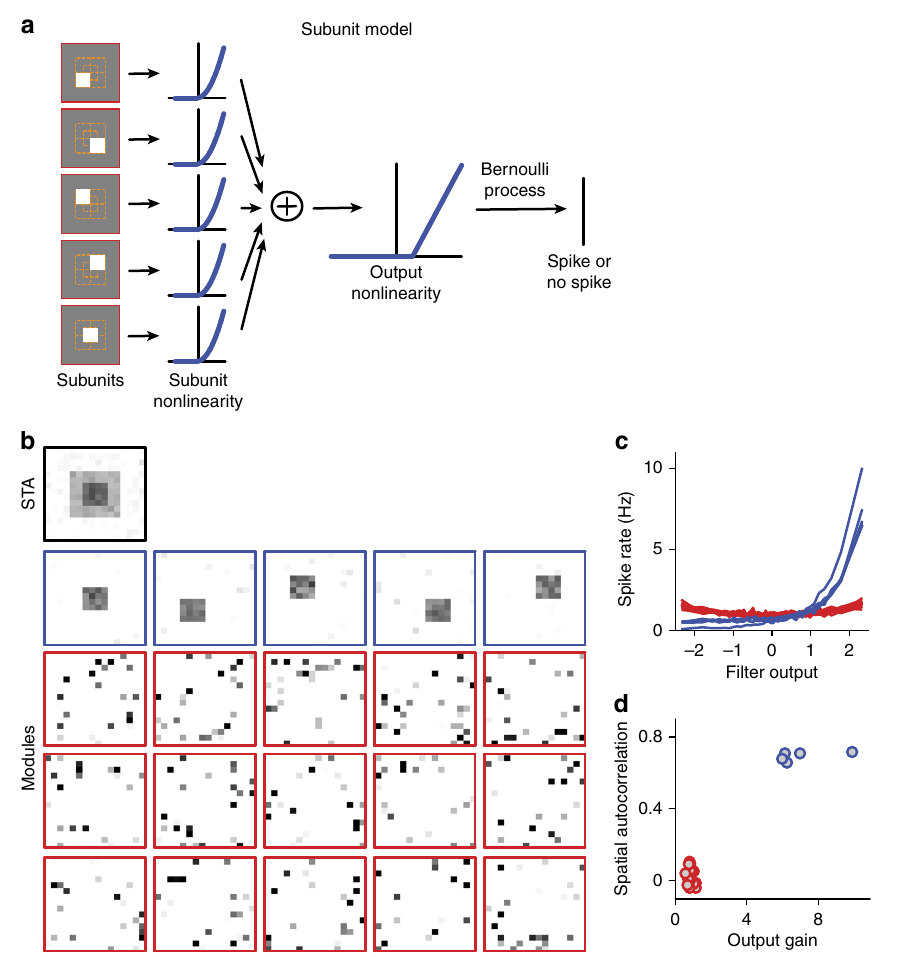
Fig. 2 Identi fi cation of overlapping subunits with STNMF for a model neuron. a Model structure. Stimuli are here spatial patterns of 16 × 16 pixels of Gaussian white noise. The model contains fi ve subunits, each covering a 4 × 4 region of the input space. The fi rst four subunits tile the central 8 × 8 region of the input space; the last subunit is located in the center of the input space, overlapping partly with each of the other four subunits. The fi lter output of each subunit is transformed by a threshold-quadratic subunit nonlinearity before summation and application of a threshold-linear output nonlinearity with a positive threshold at unity to make spiking sparse, like in the observed recordings. This yielded a spiking probability that was used to determine actual spikes according to a Bernoulli process. b – d , STNMF analysis of simulated data, using 3500 spikes. STA as well as identi fi ed modules ( b ), nonlinearities corresponding to the modules ( c ), and analysis of spatial autocorrelation vs. output gain ( d ) are shown like in Fig. 1b – d. The analysis faithfully recovered the original subunits despite their spatial